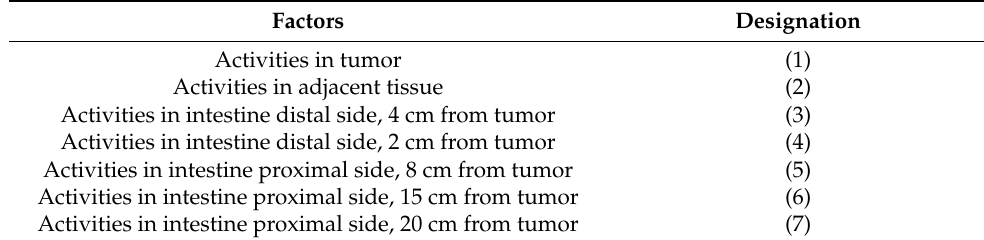
Table 1. Conditional designation of factors “Proteasome activities in the intestine locations”.